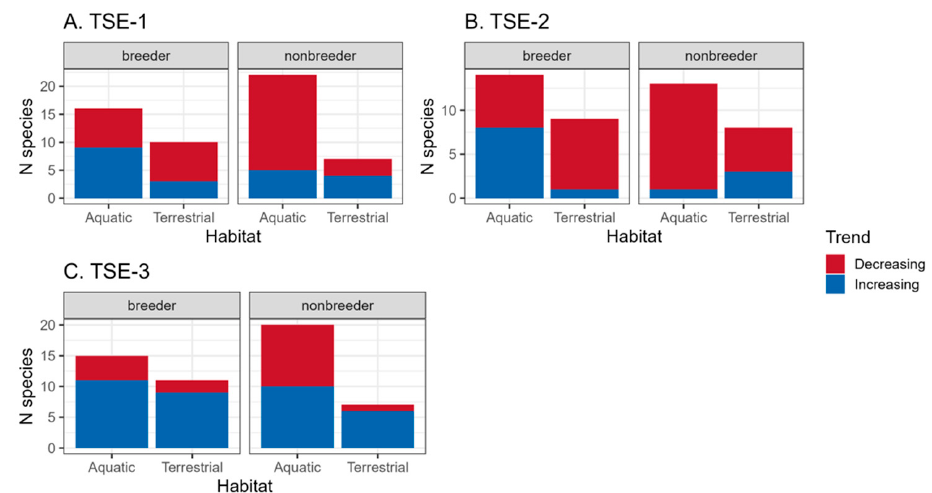
Figure 9. Number of species with increasing (blue) or decreasing (red) abundance of individuals,